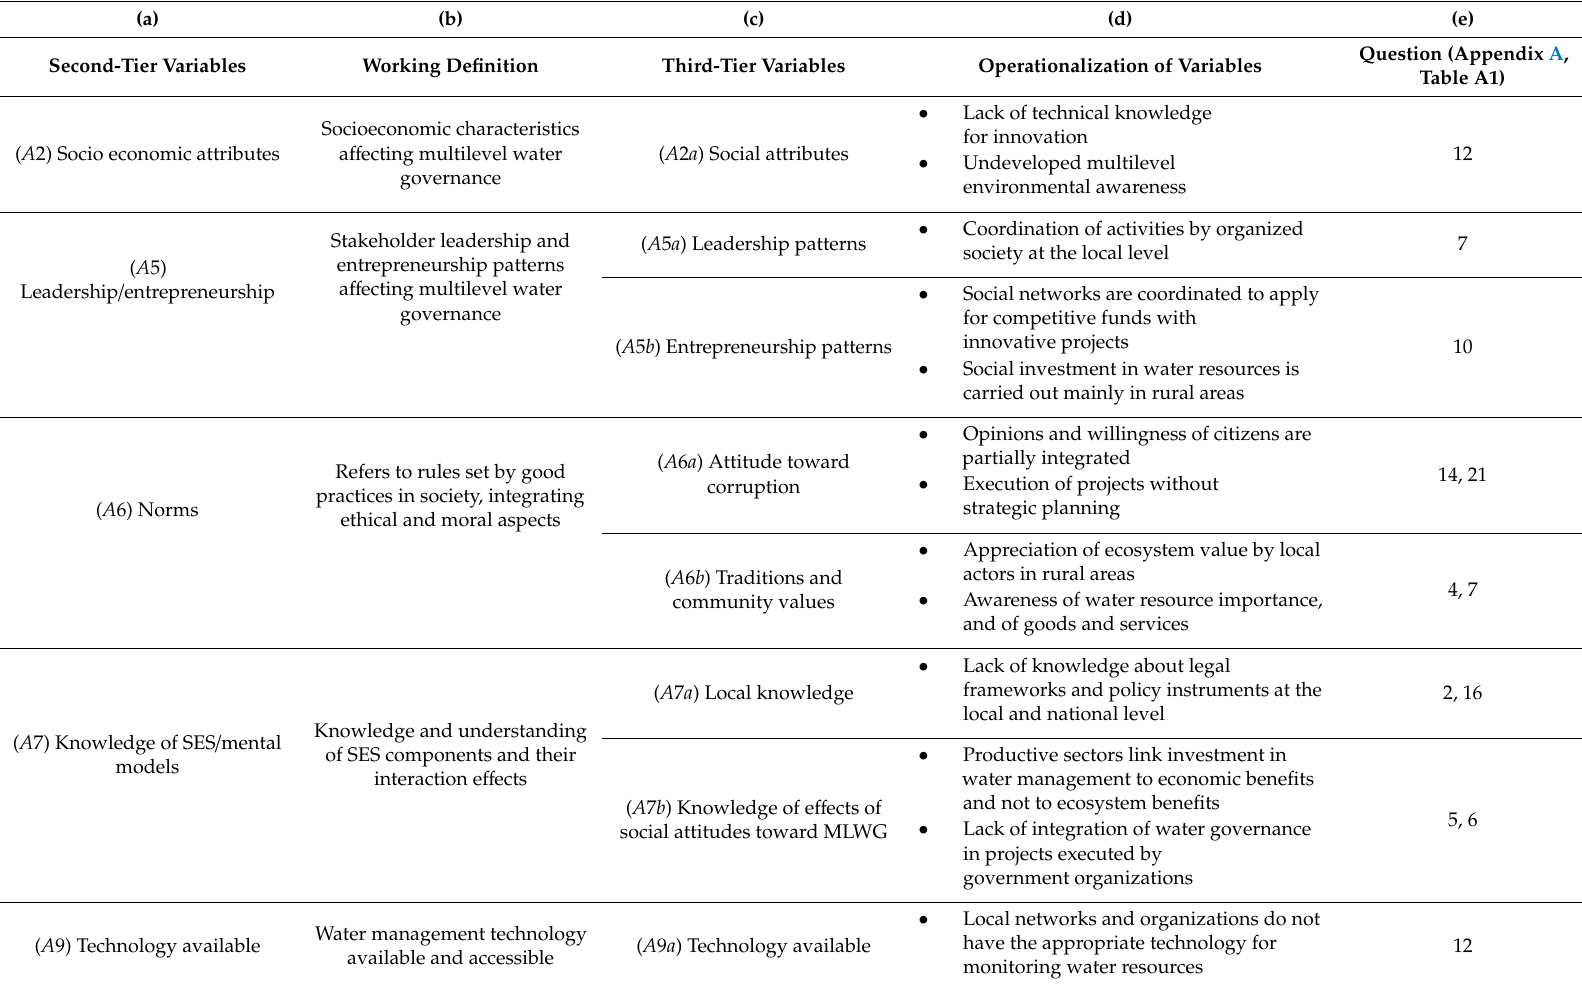
Table 2. Third-tier variables of the actors ( A ) subsystem, as identified by